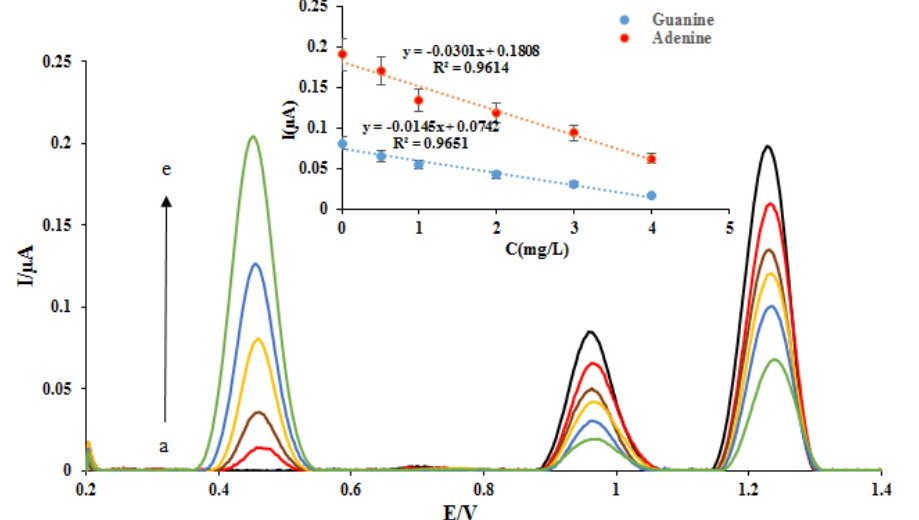
Figure 5. DPVs of DNA/rGO/GCE in the absence (black) and in the presence of (a) 0.5, (b) 1, (c) 2, (d) 3, and (e) 4 mg L —1 ELT. Insert: The plot of the peak currents of guanine (blue dots) and adenine (red dots) vs. ELT concentration.